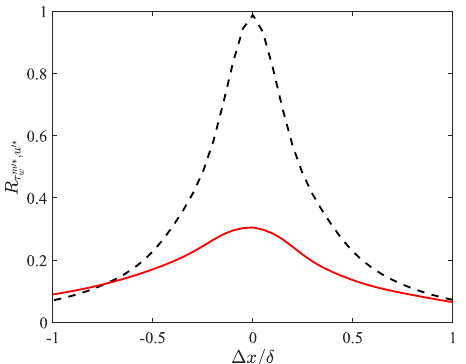
Fig. 7 Correlation of instantaneous off-wall streamwise velocity and wall- shear stress. Cross-correlation coef fi cient between the wall-shear stress τ m 0 (cid:2) u 0 (cid:2) at sampling location h m = 0.1 δ for LLWM w and streamwise velocity (red solid line) and EQWM (black dashed